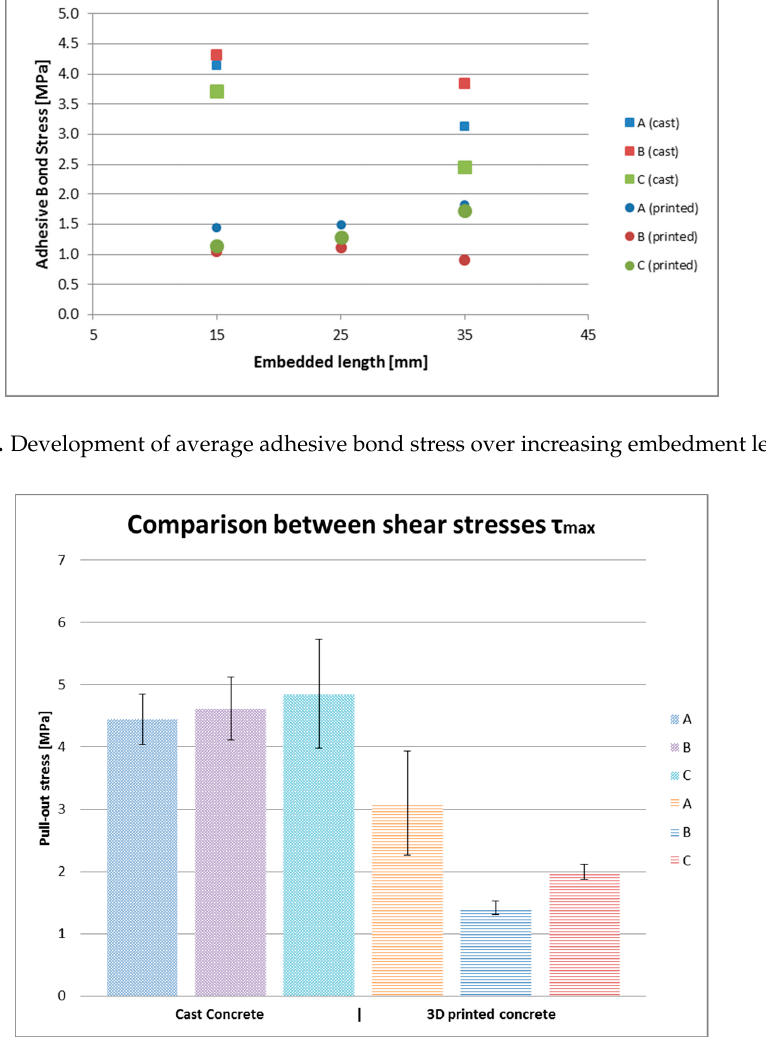
Figure 11. Comparison of average ultimate bond stress in cast and printed specimen.